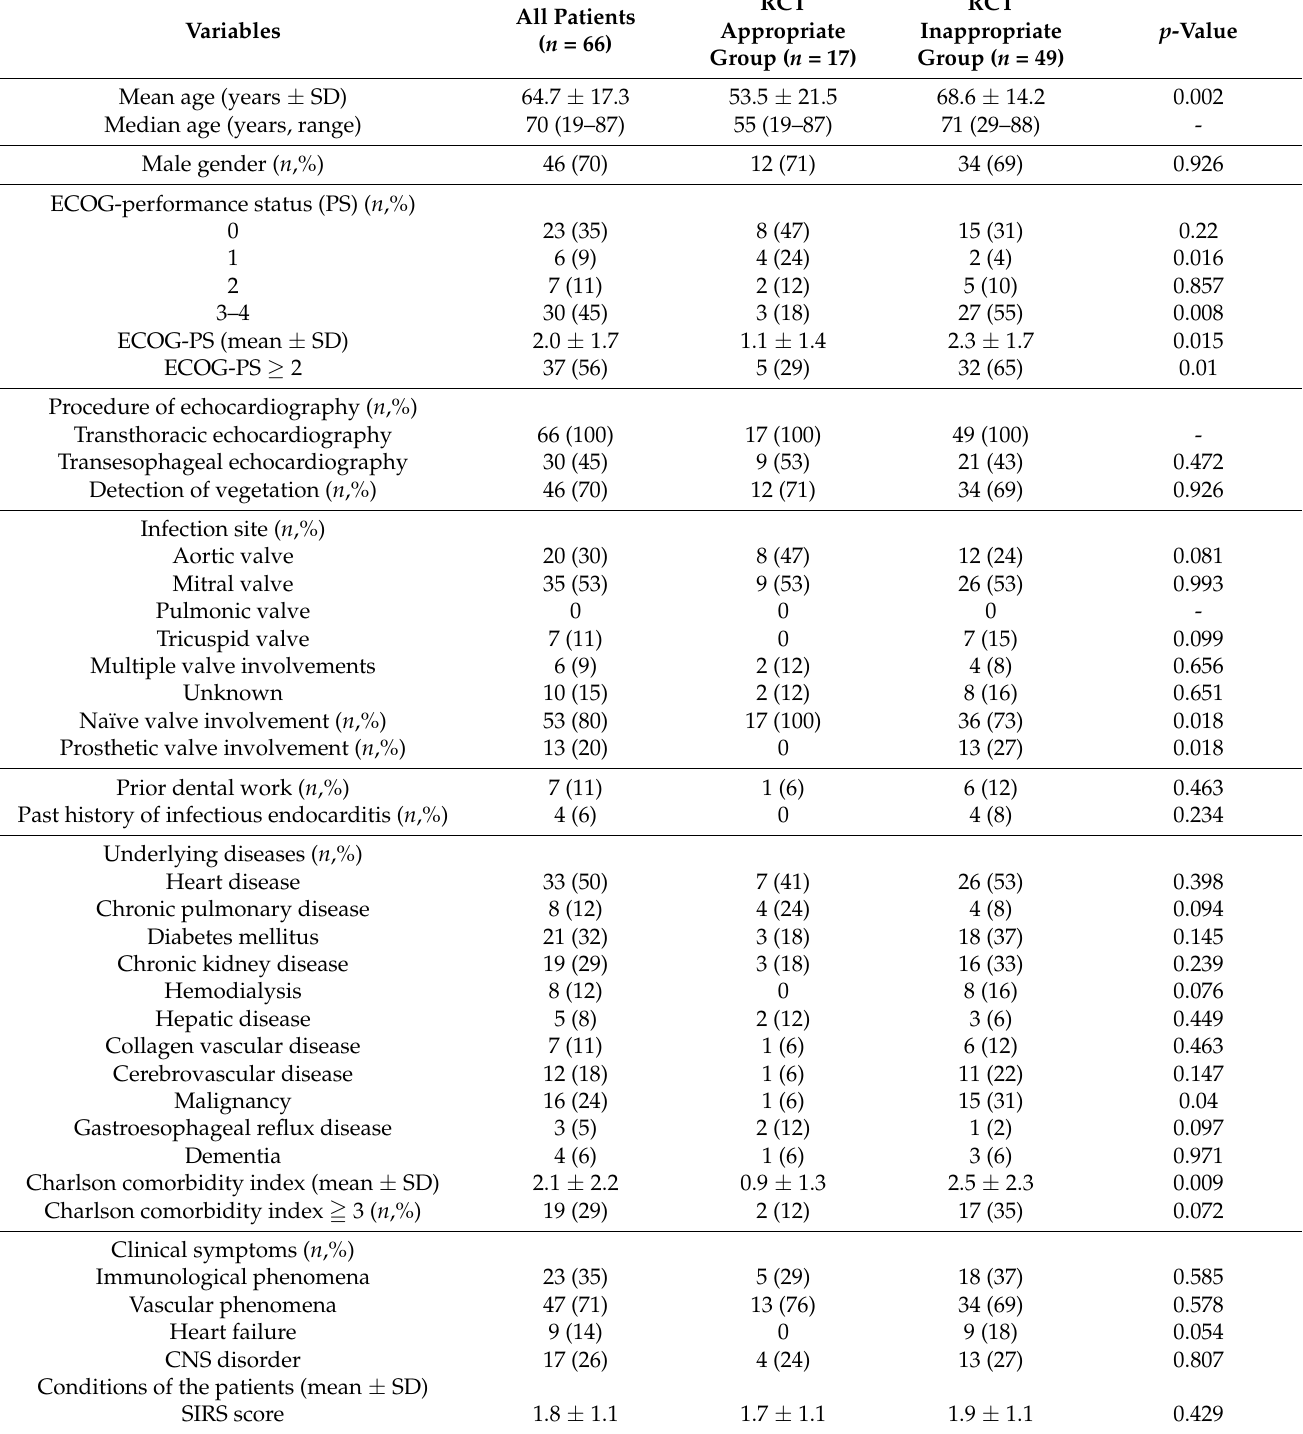
Table 1. Comparison of patients’ characteristics and outcomes among the RCT appropriate group and inappropriate